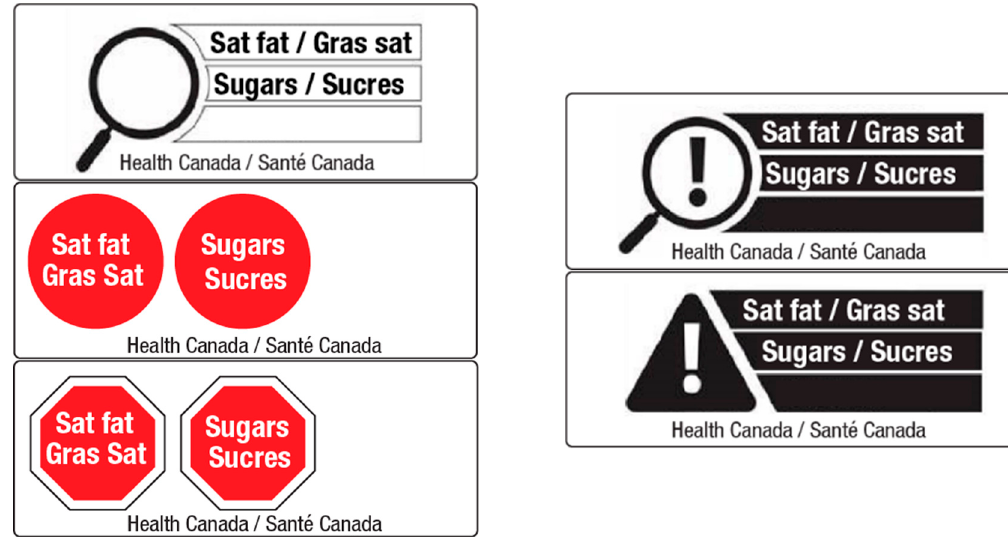
Figure 2. Front-of-package symbols * displayed on screen for the question, “Which is the best symbol for informing consumers that a product is ‘high in’ saturated fat and sugar?”. * Symbols presented in this question are identical to the five FOP symbol designs (i.e., without ‘high in’ text) tested in the experimental task (see Figure 1). Note that the government attribution (‘Health Canada’) was present for all participants, regardless of country of origin.